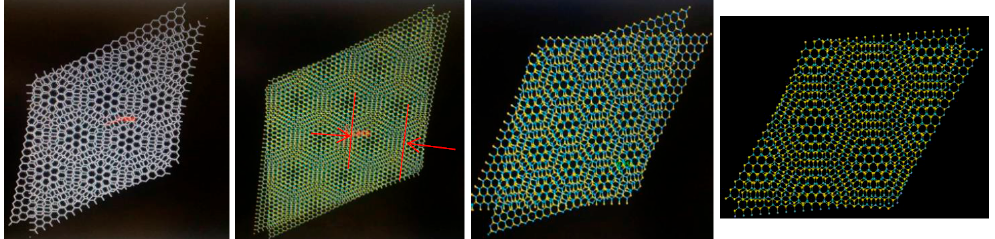
Figure 1. Moiré pattern as formed by angular rotation of 2D layered materials molecular models. From left to right: graphene, tungsten diselenide (WSe 2 ), tungsten disulfide (WS 2 ) and molybdenum disulfide (MoS 2 ) at 19° of rotation.